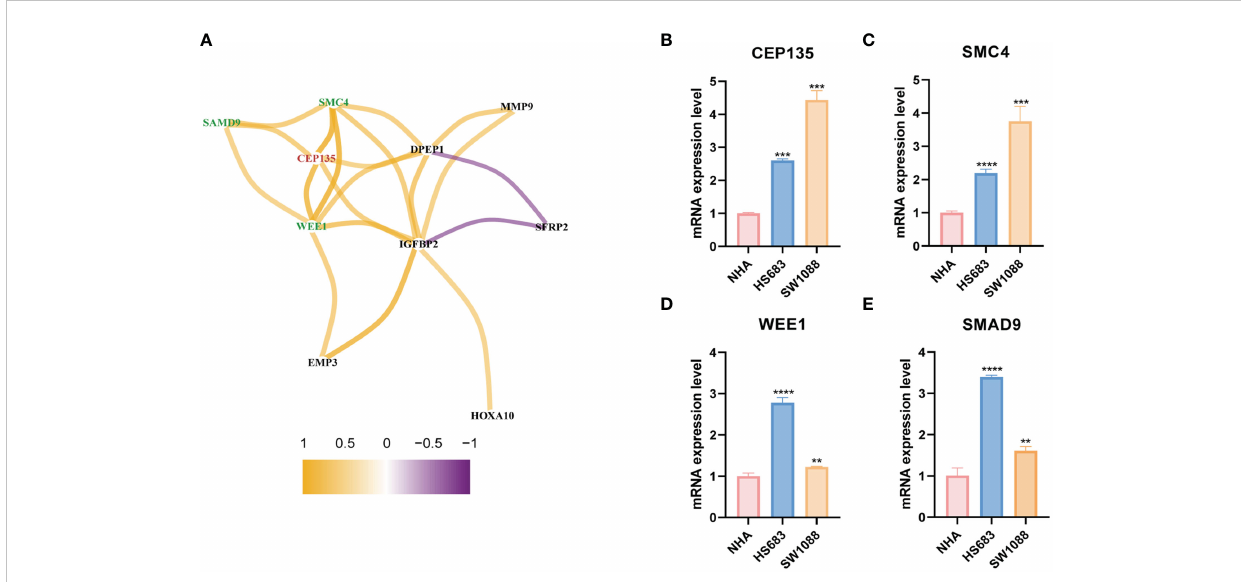
FIGURE 11 The differential expression veri fi cation of potential CRGs team by qRT-PCR. (A) The genes co-expressed network of CEP135 and 12 signature genes taking correlation coef fi cient r>0.5 as the threshold value. red represents the key gene, green represents the three strongest correlation genes with the key gene. (B – E) Differential expression veri fi cation of CEP135, SMC4, WEE1 and SMAD4 in SW1088, HS683 and NHA cells using qRT-PCR. CRGs, centrosome related genes. **p < 0.01; ***p < 0.001; and ****p < 0.0001. qRT-PCR data are means ± SD, with n =